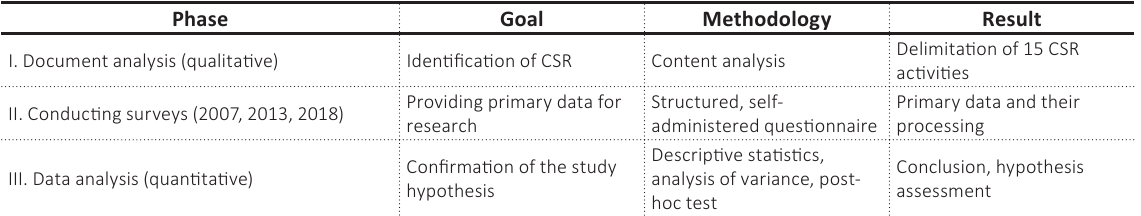
Table 2. The research process and